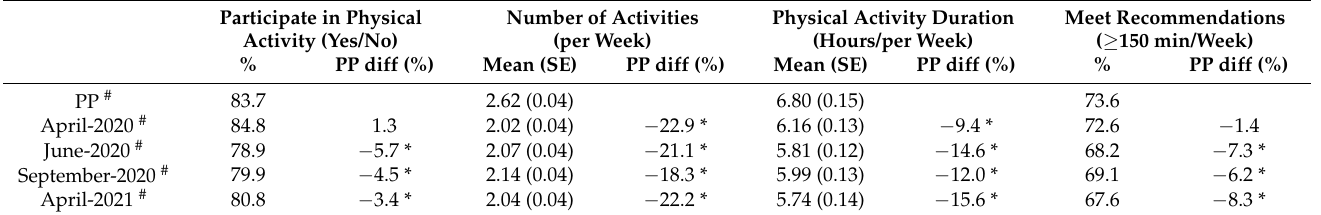
Table 2. Changes in adult physical activity during the first year of the COVID-19 pandemic in New